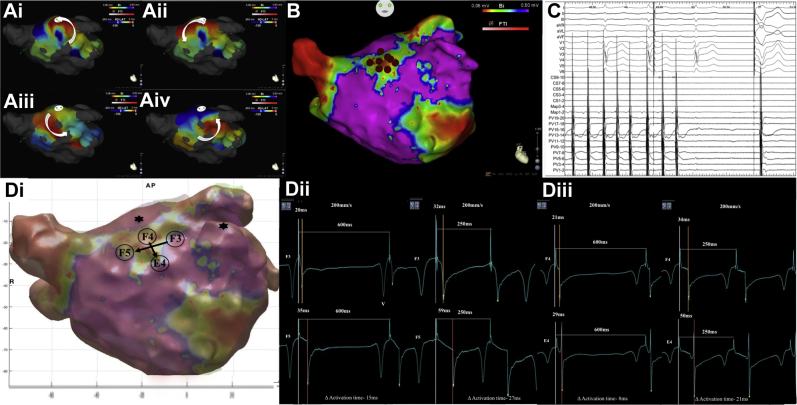
A: i–iv: Still CARTOFINDER map demonstrating a rotational driver at the anterior roof (B) in an area of LVZ as shown on the bipolar voltage map (C), where ablation resulted in atrial fibrillation termination to sinus rhythm on the Bard electrograms. D: i: Replicated CARTO geometry created in MATLAB demonstrating site of rate-dependent conduction velocity (CV) slowing at the anterior roof in an area of LVZ (0.2–0.5 mV) (F3–F5 electrodes; vertical and F4–E4 electrode: horizontal). ii: Electrograms obtained at F3 and F5 electrodes during left atrial appendage pacing at PI 600–250 ms show an increase in activation time difference of 12 ms (80% increase) between the 2 electrodes when reaching PI of 250 ms. (iii) Electrograms obtained at F4 and E4 electrodes during roof pacing at PI 600–250 ms show an increase in activation time difference of 13 ms (163% increase). LVZ = low-voltage zone; PI = pacing interval; V = far-field ventricular signal.